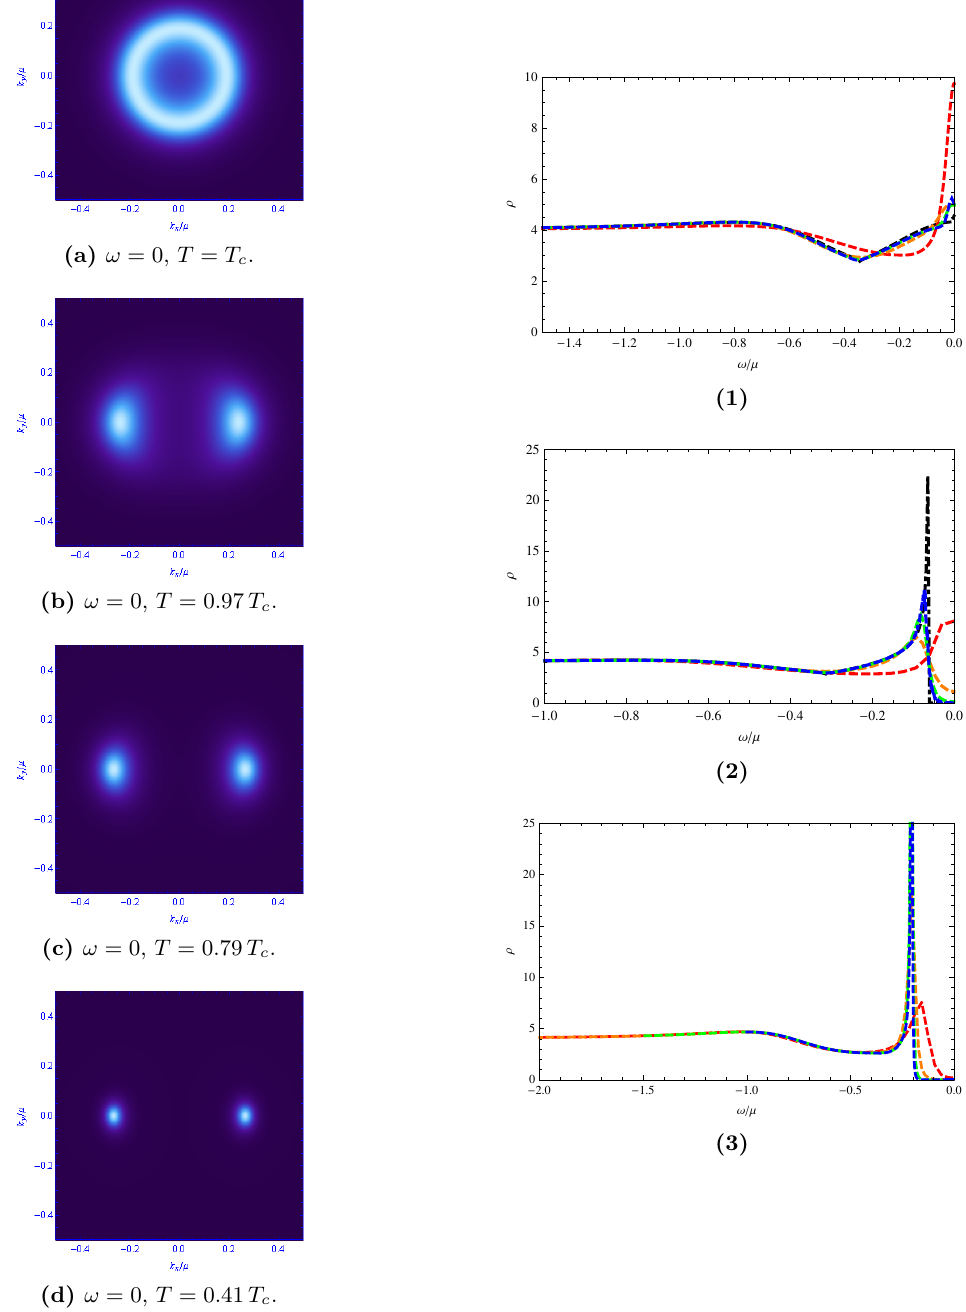
Figure 15. The spectral function at (cid:12)xed (cid:21) = (cid:21) c = 0 : 62. Left: the spectral surface ! = 0 at di(cid:11)erent temperatures. Right: (1) (cid:26) as a function of ! at ( k x ; k y ) = ( k (cid:3) ; 0), notice that the black curve ( T = 0) also presents a delta-like peak at ! = 0 which is not depicted in the (cid:12)gure; (2) (cid:26) as a function of ! at ( k x ; k y ) = (0 : 20 ; 0 : 10) (cid:22) ; (3) (cid:26) as a function of ! at ( k x ; k y ) = (0 : 20 ; 0 : 40) (cid:22) . Each graph in these plots corresponds to the temperatures: T = T c (red), T = 0 : 97 T c (purple) T = 0 : 76 T c (orange), T = 0 : 38 T c (green), T = 0 : 28 T c (blue), T = 0 (black).